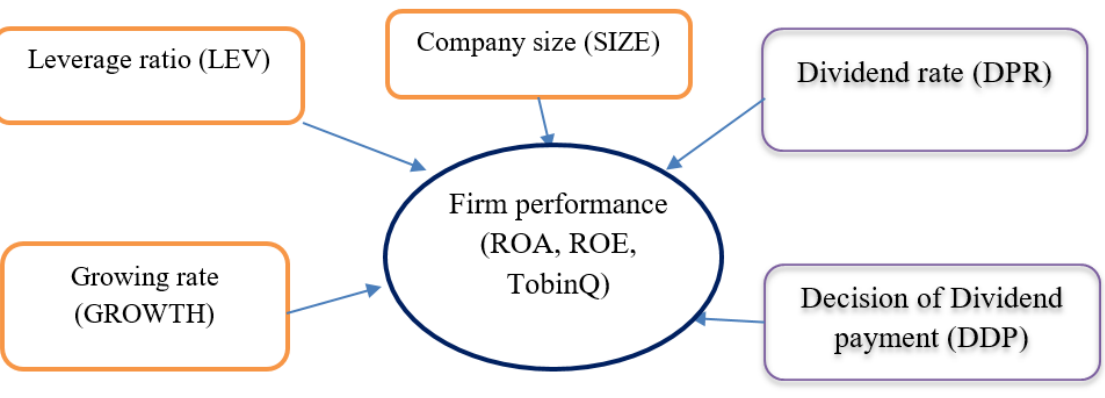
Figure 1. The proposed research model.